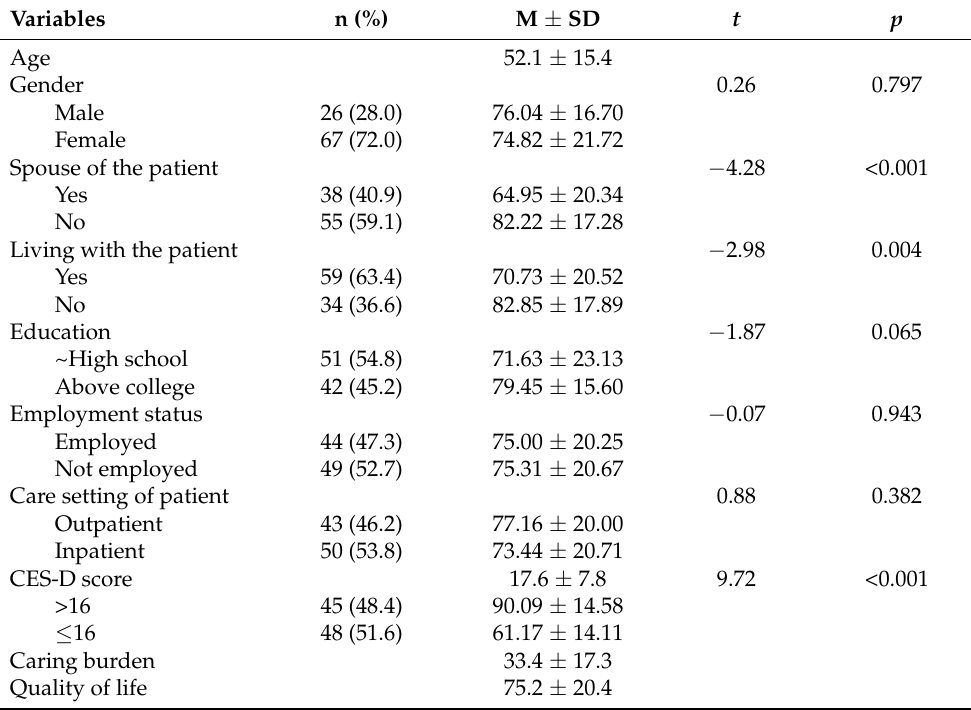
Table 1. Quality of life according to caregivers’ general